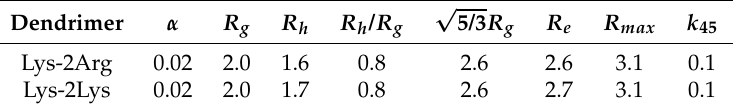
Figure 3. The global characteristics for Lys-2Arg as functions of temperature: ( a ) the mean-squared radius of gyration R g , ( b ) the characteristic ratio R h (in the Kirkwood approximation) to the radius of gyration R g for Lys-2Arg for three alternative ways of calculations: taking into account the heavy atoms of this dendrimer only, for heavy atoms in the dendrimer and ions, for all heavy atoms in the system (carbons, nitrogens, and oxygens of the dendrimer; Cl ions; oxygens of water molecules). Table 3. The characteristics of the Lys-2Arg and Lys-2Lys dendrimers: the asphericity parameter α , the radius of inertia R g (nm), the hydrodynamic radius R h (nm), the ratio R h / R g , √ the rigid-sphere-approximation 5/3 R g (nm), the position of terminal groups R e (nm), the radius R max (nm) and the congretation coefficient k 45 at temperature 310